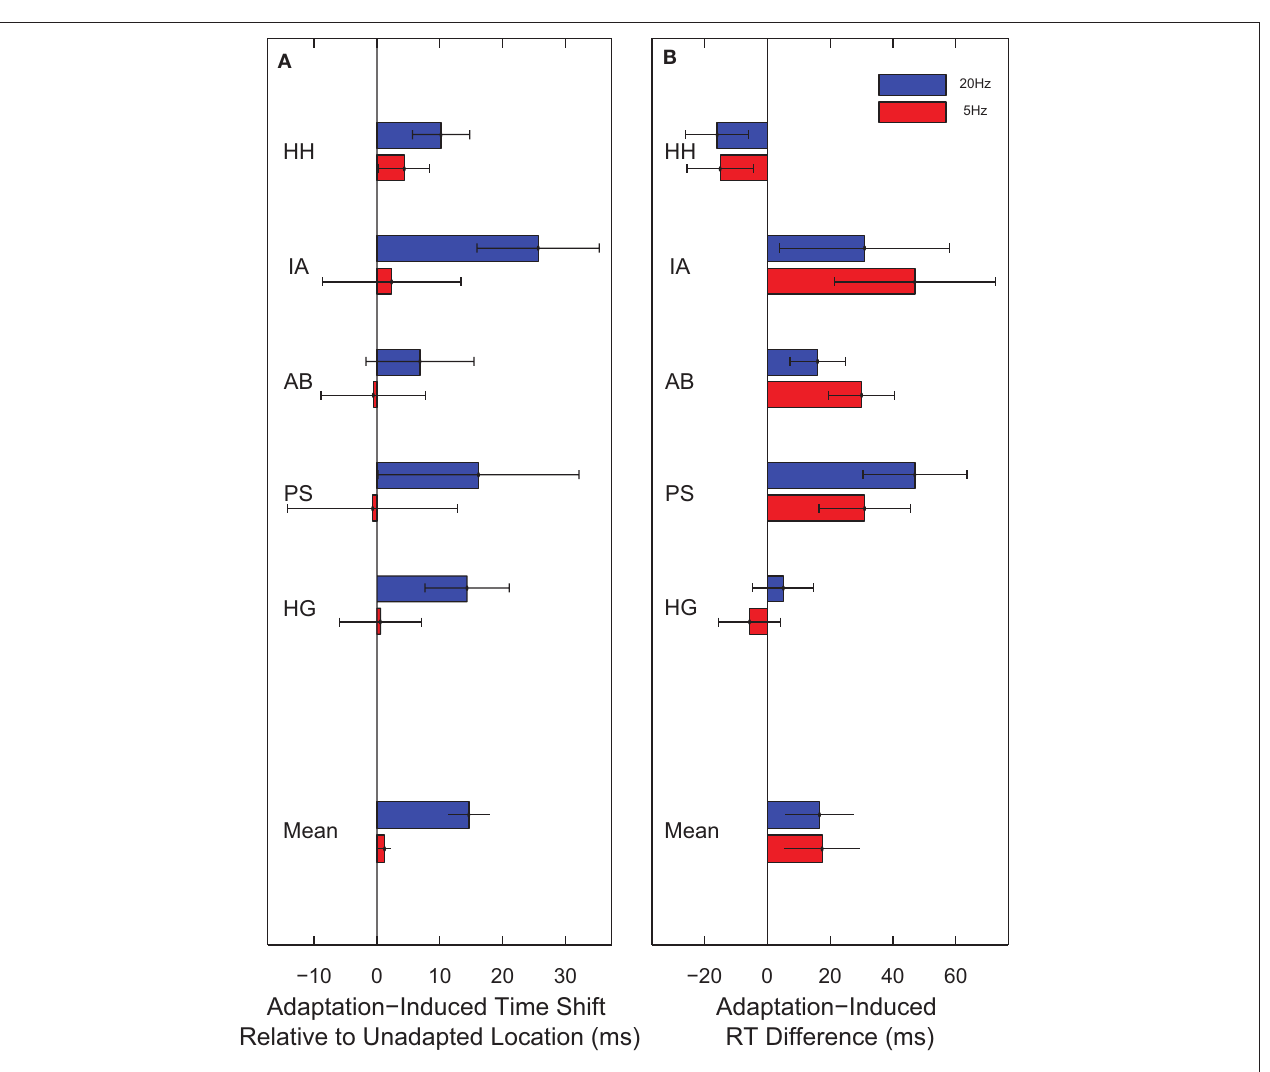
Figure 4 | Temporal decoupling relative to a transient. (A) In Experiment 3, observers reported the time on a cued clock. When the cued clock was presented in a region adapted to 20-Hz flicker, the reported time was 15 ms later than when the cued clock was presented in an unadapted location. No such